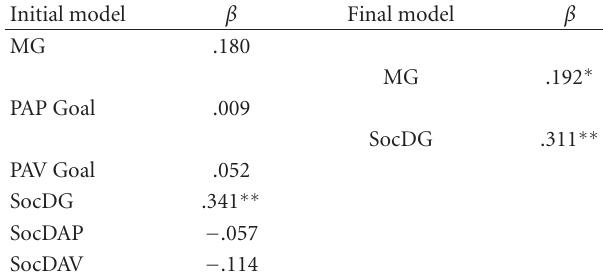
Table 5: Summary of stepwise regression analysis using backward elimination approach for academic achievement goals, social goals, and